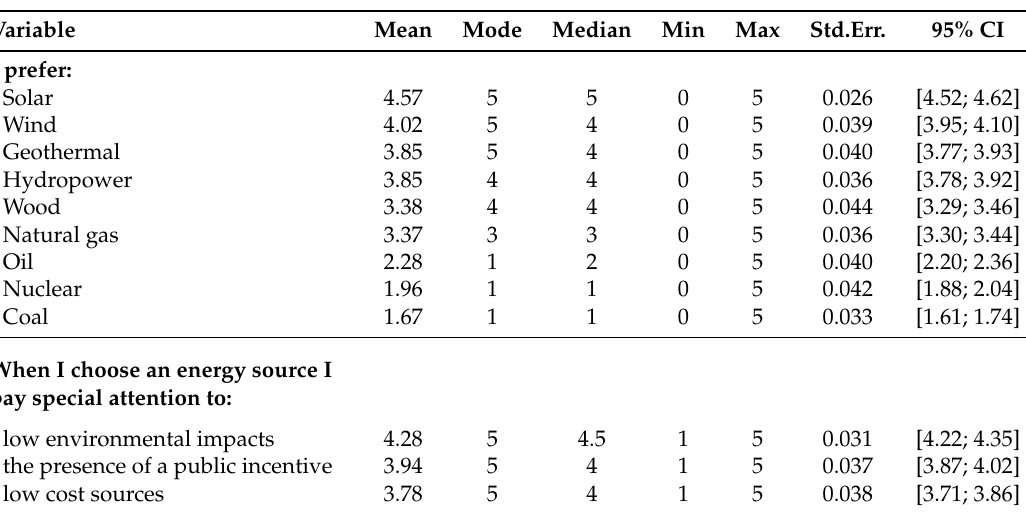
Table 3. Respondents’ general opinion on energy sources. Likert scale ranging from 1 (disagreement) to 5